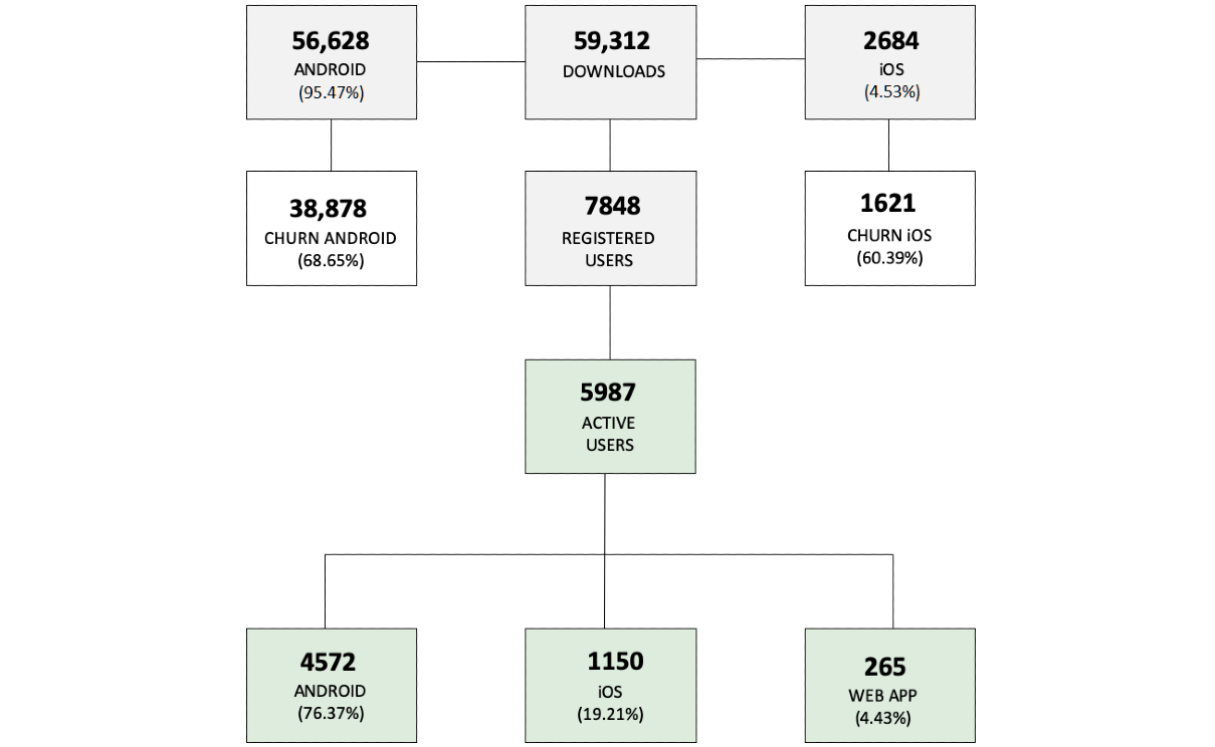
Figure 2. Distribution of downloads, registered users, and active users by operating system and app during the study